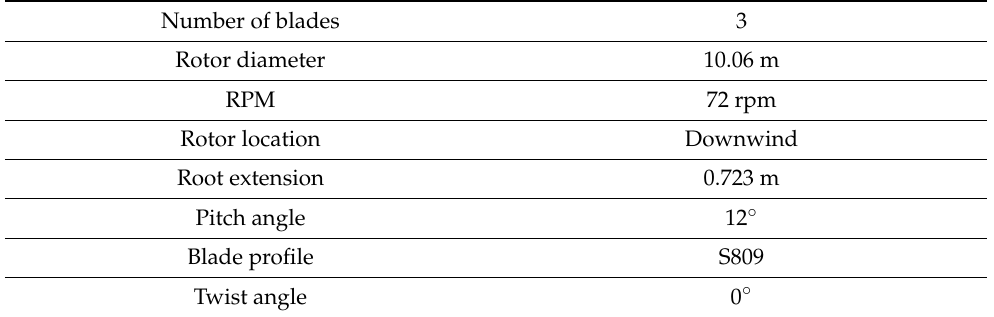
Table 1. Rotor description.